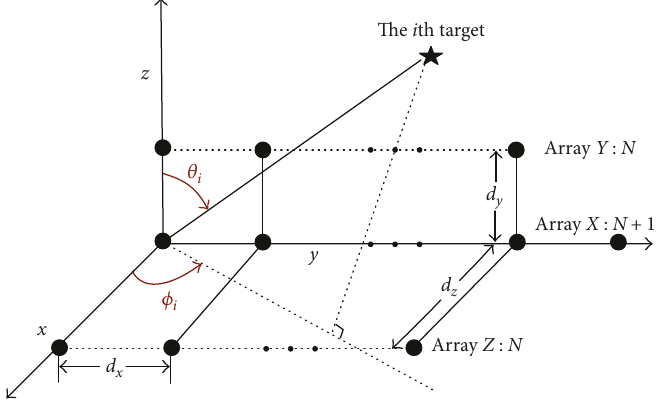
Figure 1: Sketch map of array